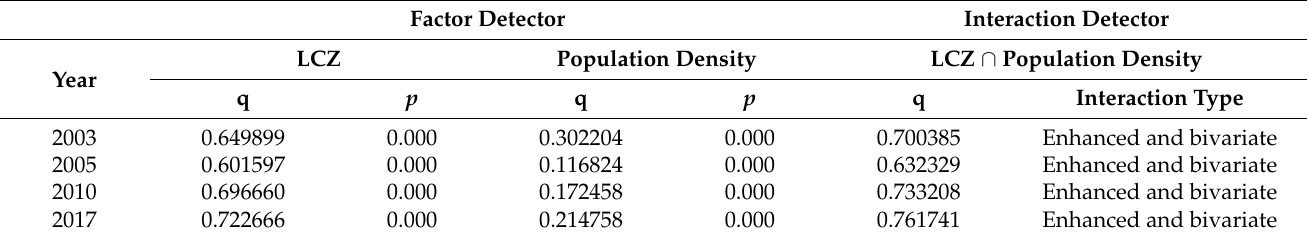
Table 6. Factor and interaction detection results (dependent factor: sUHI intensity; independent factors: LCZ and population density).